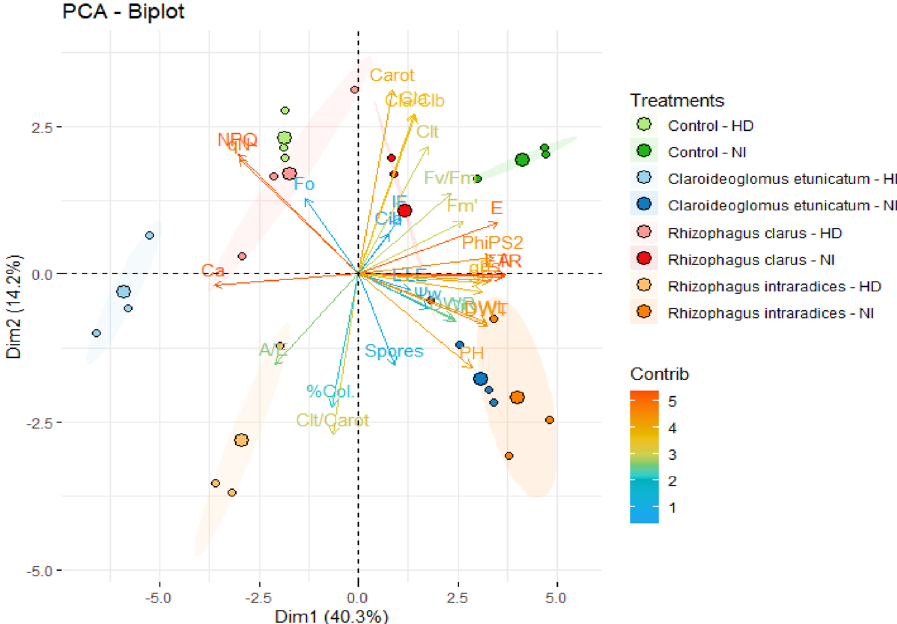
Figure 6. PCA biplot of the first and second dimensions of corn plants (Zea mays) submitted to different water treatments and inoculated with AMF after reirrigation. HD Hydric deficit and NI normaly irrigated.